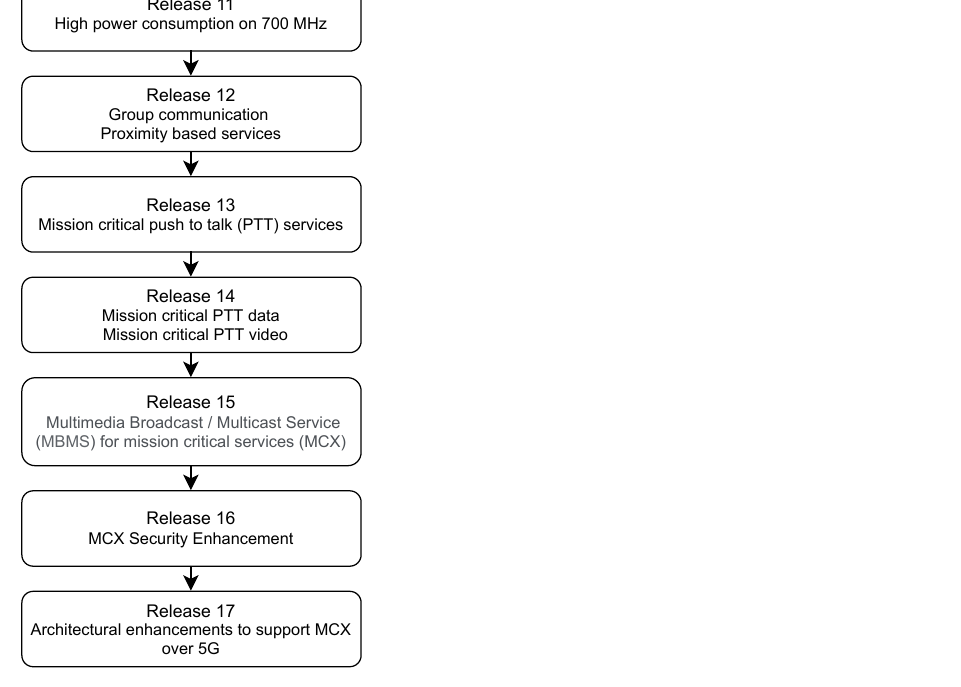
Figure 2. Evolution of the 3GPP specifications for missions critical/emergency scenarios using proximity-based services under each release from